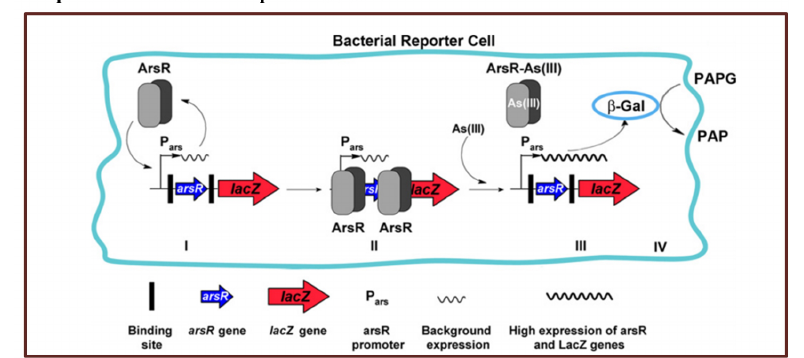
Figure 4. Pictorial presentation of the working scheme of the As(III) bioreporter